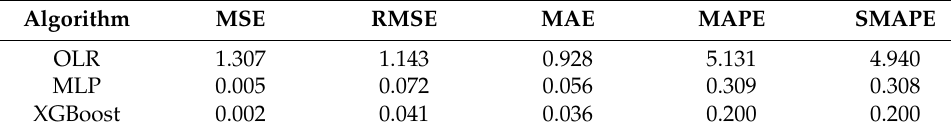
Table 7. Evaluation indexes of each algorithm in Tianjin.